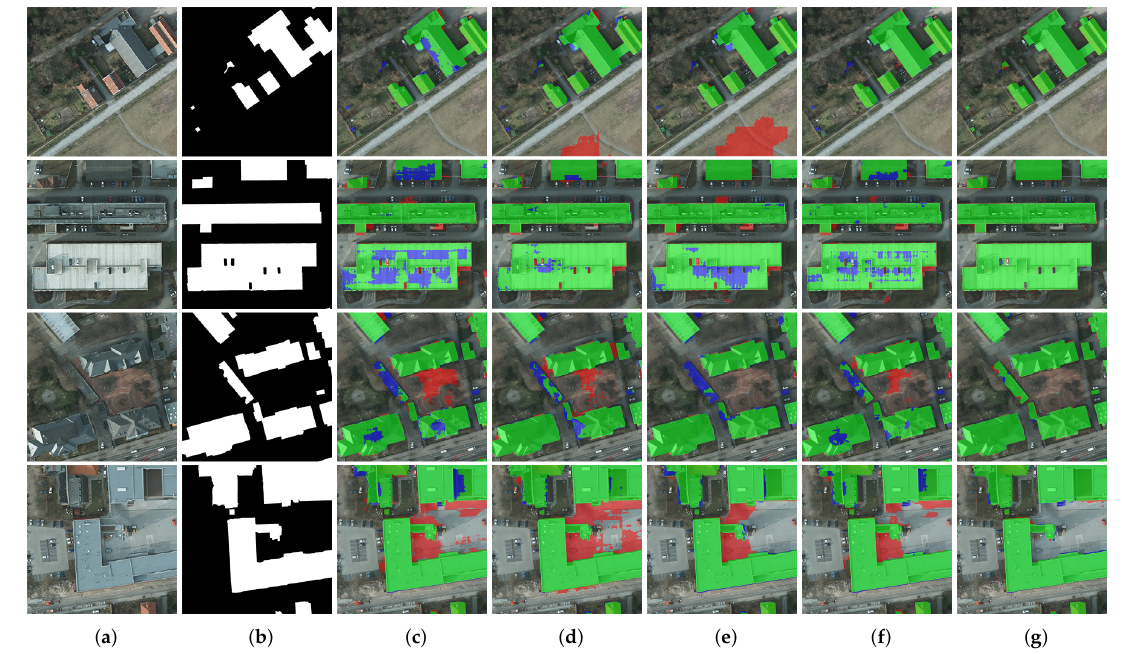
Figure 10. Close-up views of the results obtained by different methods on the Potsdam dataset. Images and results shown in ( a – g ) are the subset from the selected regions marked in Figure 9a. ( a ) Original image. ( b ) Ground-truth. ( c ) U-Net. ( d ) DeepLab-v3+. ( e ) DANet. ( f ) MA-FCN. ( g )